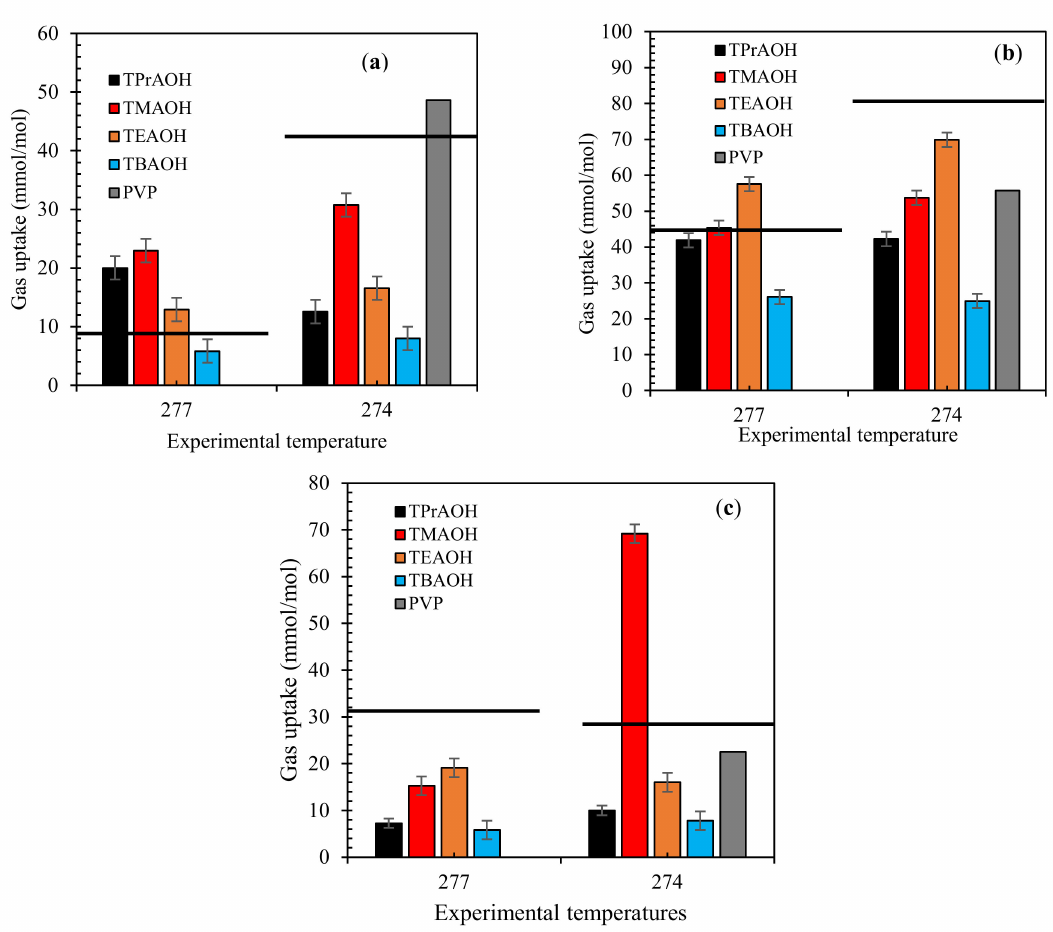
Figure 4. Effect of 1 wt% QAHs on gas uptake by mixed gas systems at different temperatures for ( a ) 70% CH 4 + 30% CO 2 , ( b ) 50% CH 4 + 50% CO 2 , and ( c ) 70% CH 4 + 30% CO 2 , and comparison with the industrial inhibitor PVP. The solid lines represent pure